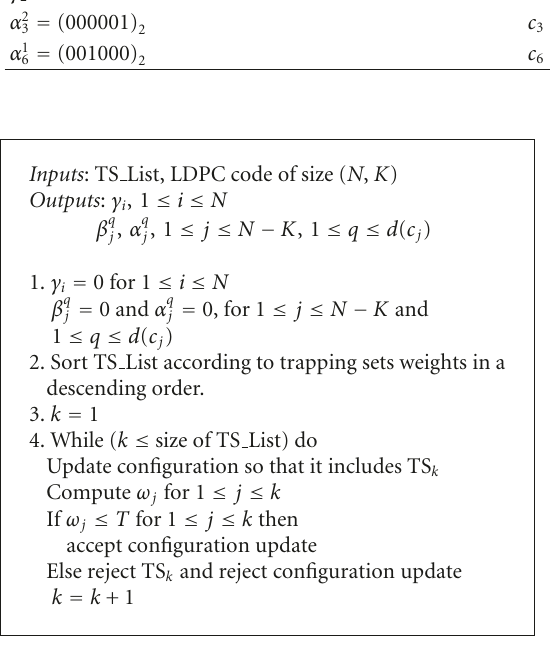
Algorithm 3: Nodes configuration algorithm.